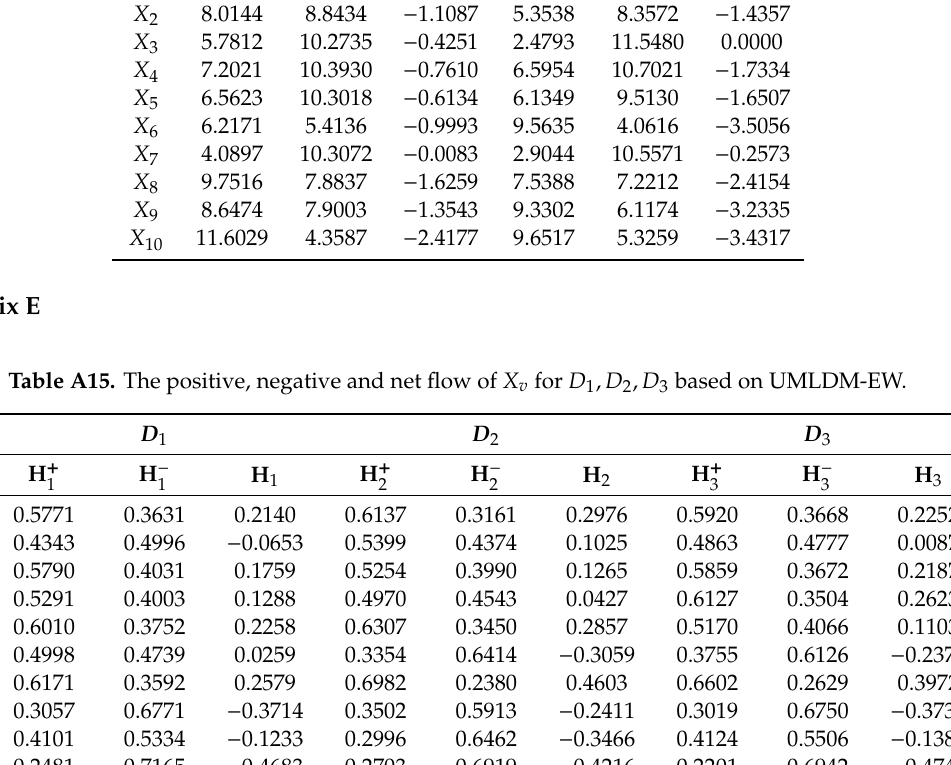
Table A14. MMED ( SF k